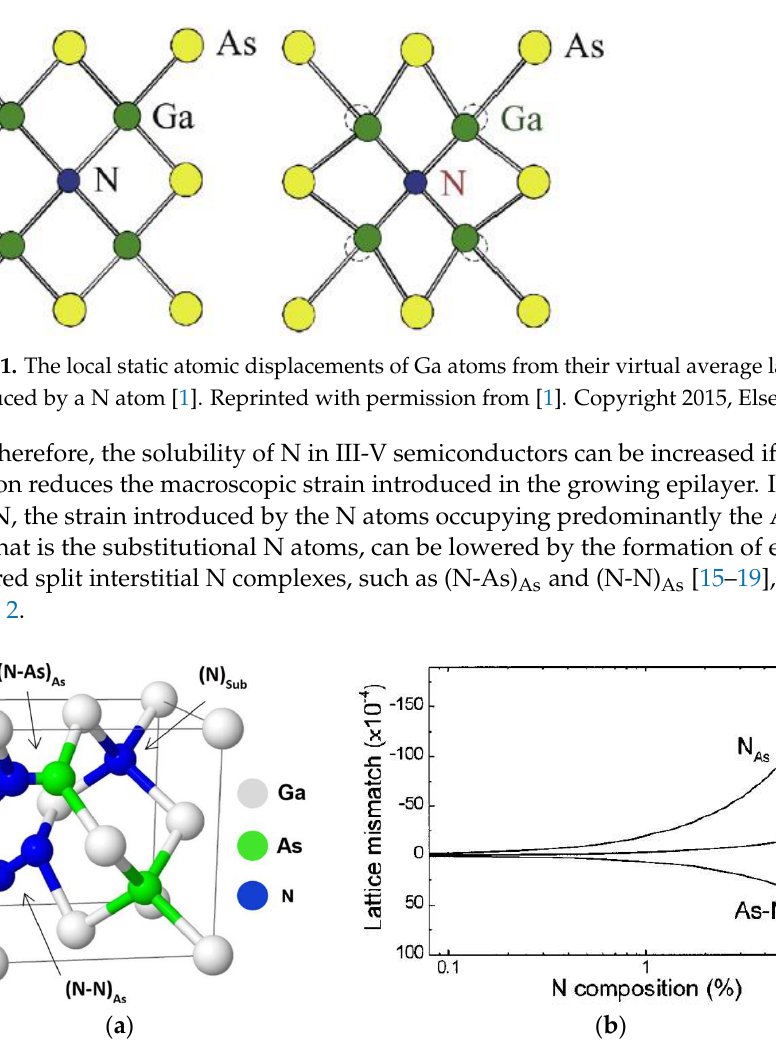
Figure 2. Nitrogen related defects in GaAsN: ( a ) split interstitial N complexes (N-As) As and (N-N) As [18]; ( b ) lattice mismatches between GaAsN and GaAs caused by substitutional nitrogen N As , com- plexes (N-N) As and (N-As) As for different N content [17]. Reprinted with permission from [17,18]. Copyright 2015, 2001, AIP Publishing.